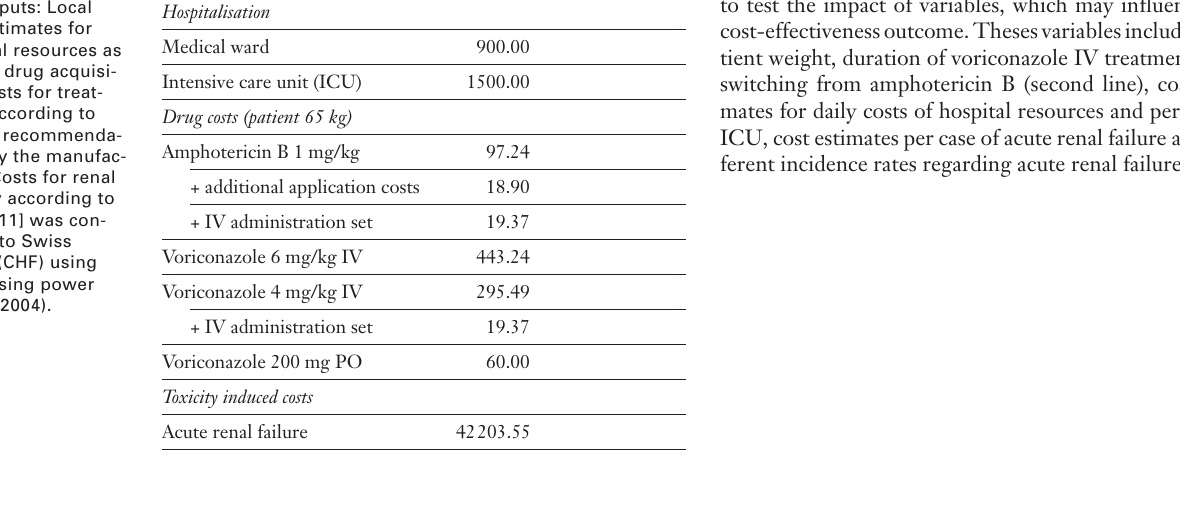
Cost inputs: Local cost estimates for hospital resources as well as drug acquisi- tion costs for treat- ment according to dosing recommenda- tions by the manufac- turer. Costs for renal toxicity according to Bates [11] was con- verted to Swiss francs (CHF) using purchasing power parity (2004).